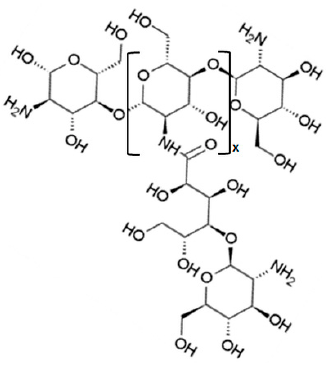
Figure 4. Galactosylated chitosan. Table 2. Galactosylated-chitosan nanoparticles designed for the treatment of HCC and liver-targeting: the therapeutic/theranostic effect and cell cultures used in the study are reported for each reference.